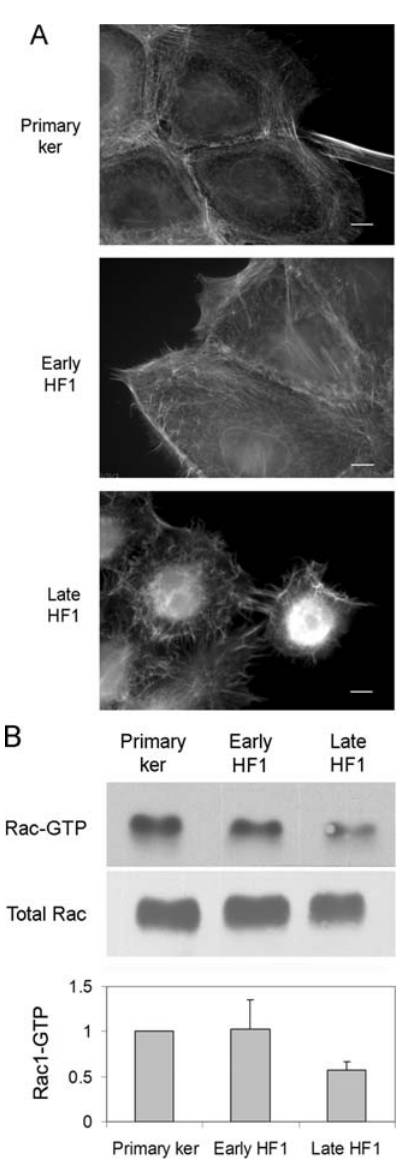
Figure 5. Disruption of Actin organization in late HF1 cells is associated with reduced Rac1 activity. A. Representative images of phalloidin staining for F-Actin in the primary keratinocytes, early and late HF1 cells. Bar=15 m m. B. Western blot analysis of Rac1. Upper panel shows activated, GTP-loaded Rac1 pulled-down with GST-PBD. Lower panel shows total Rac1 levels in whole cell lysates before pull down. Graph shows average active, GTP-loaded Rac1. Error bars represent standard errors of three independent